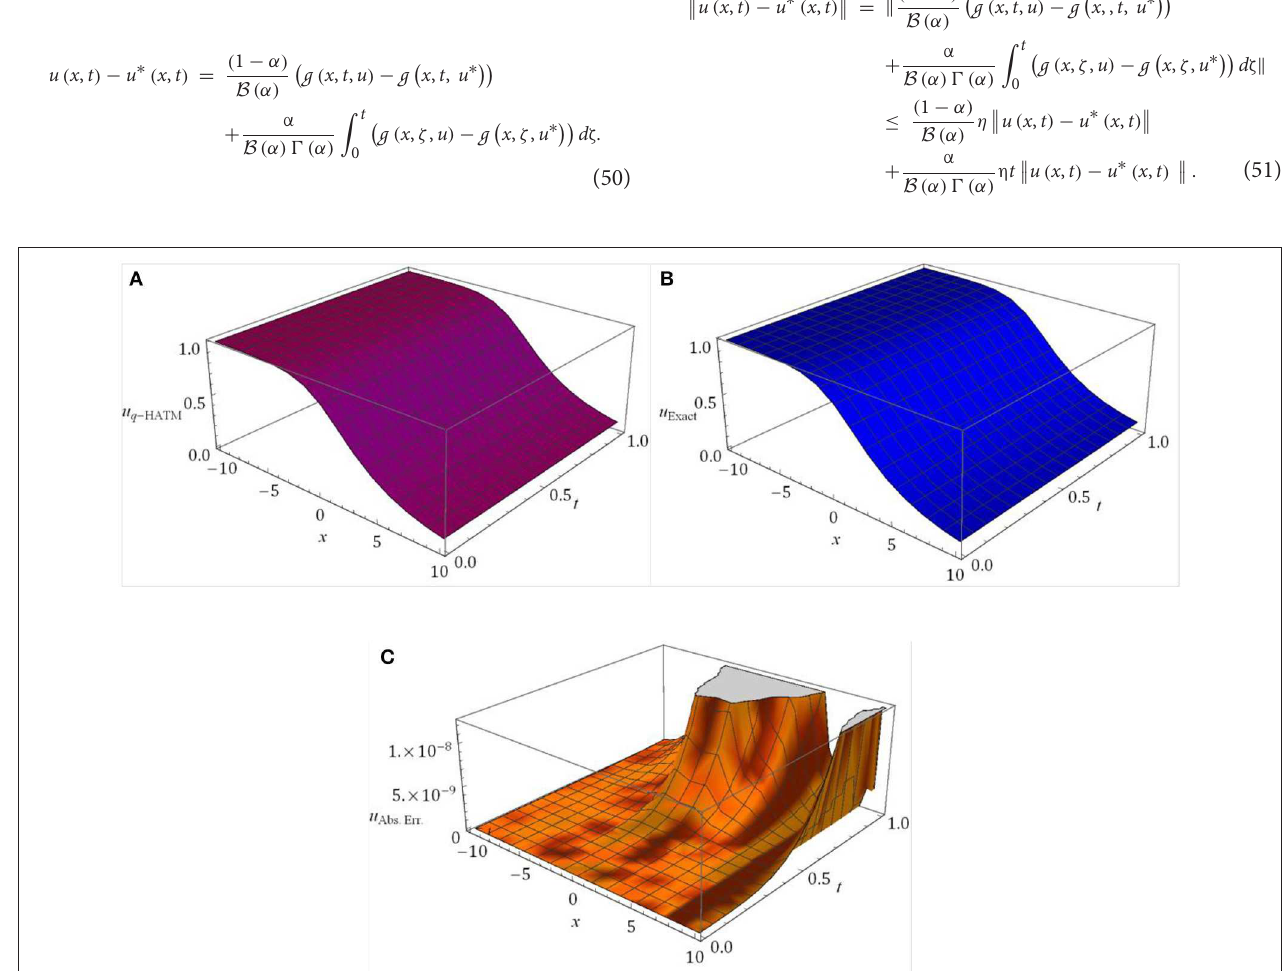
FIGURE 2 | Surfaces of (A) u q − HATM , (B) u Exact (C) u Abs . Err . = for FR equation considered in Case 2 at ℏ = − 1, n = 1 and α = 1.